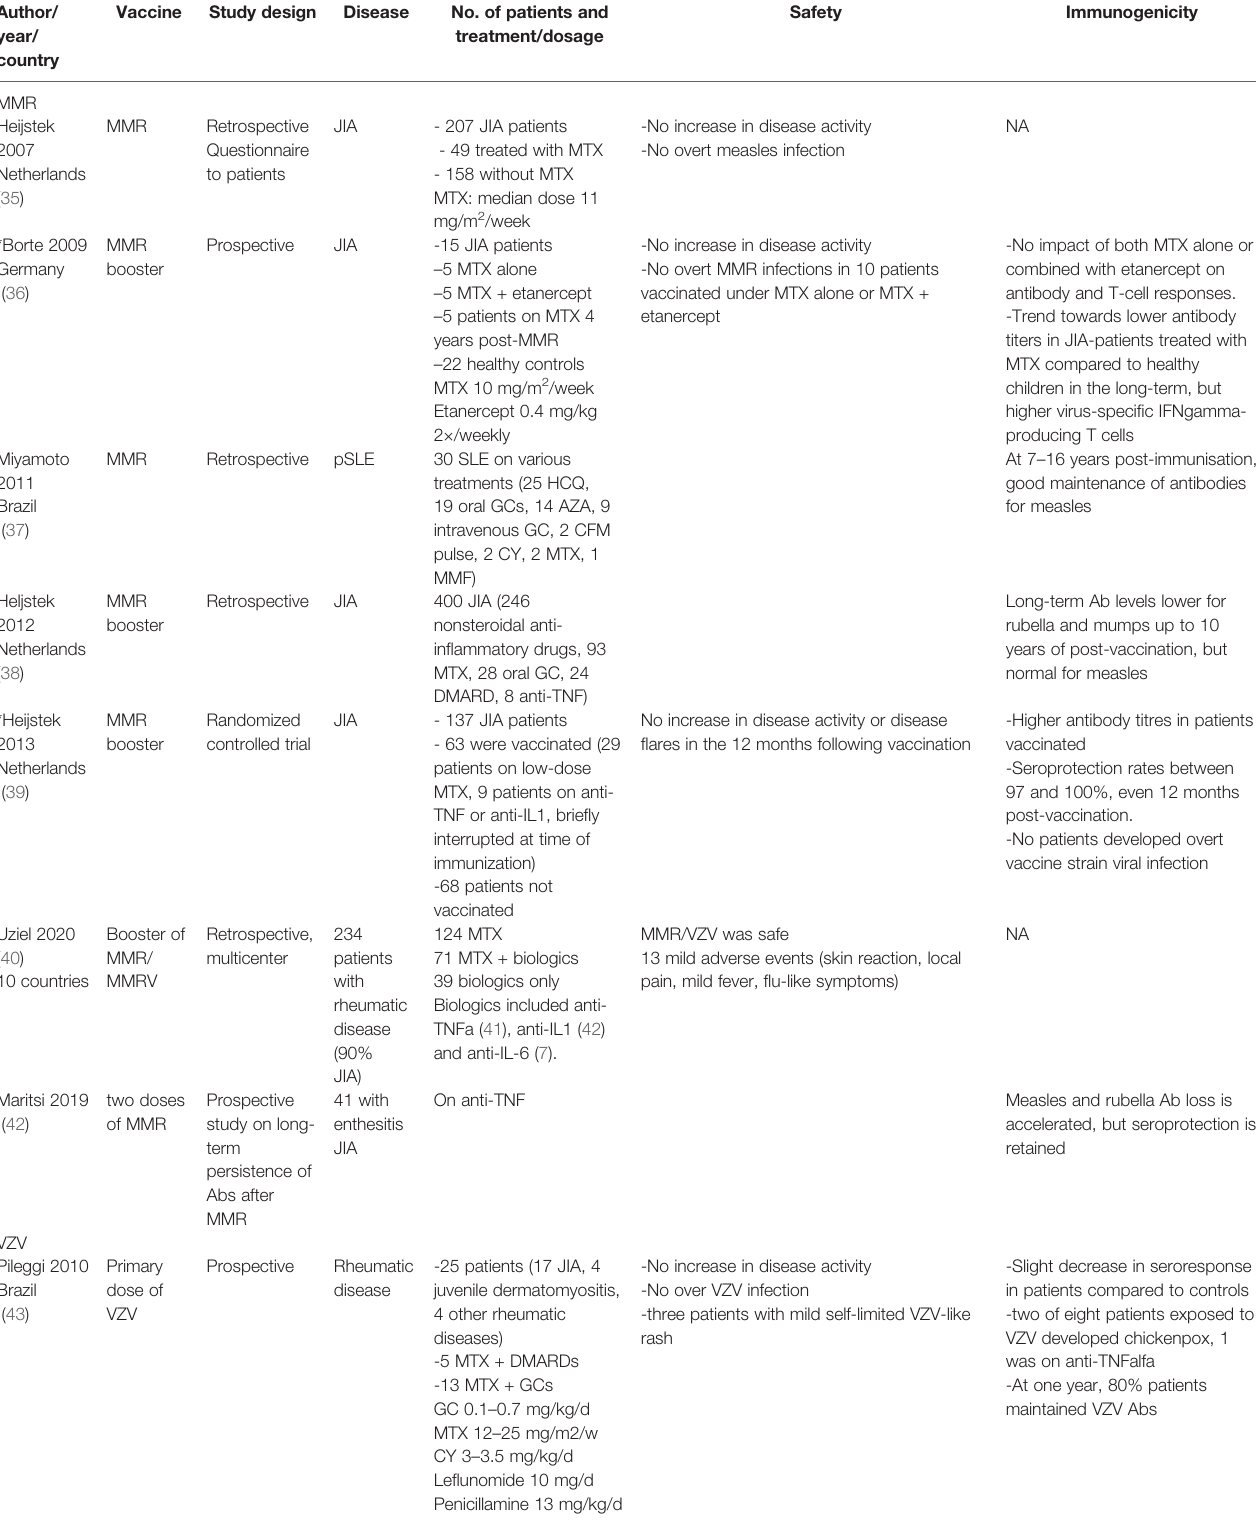
TABLE 2 | Summary of previous studies on live-attenuated vaccines in immunocompromised